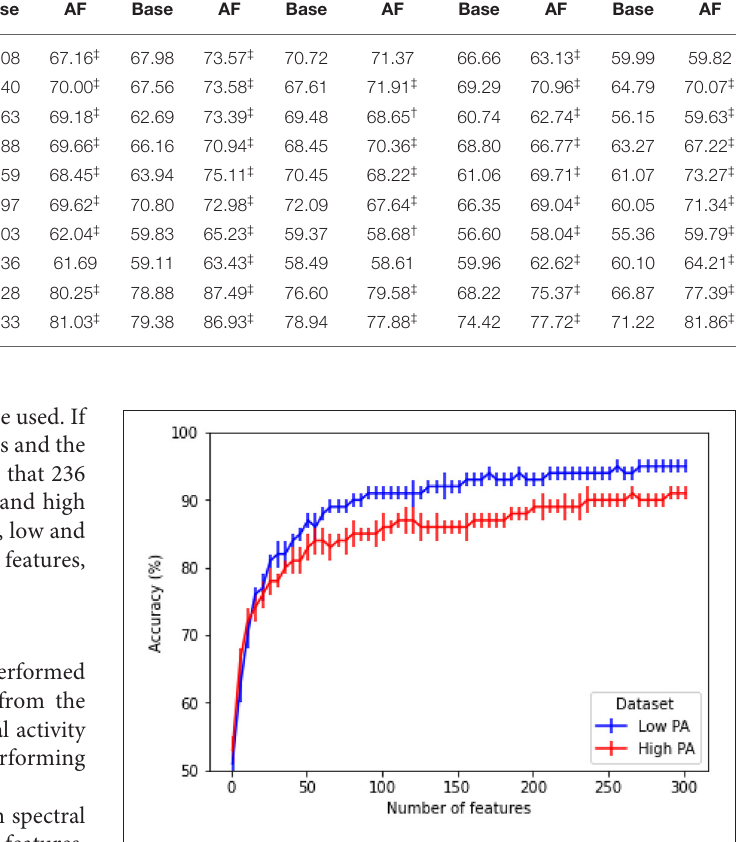
TABLE 2 | SVM mental workload classification accuracy for different feature and enhancement algorithm configurations. Raw ASR ADJUST HAPPE ASR_ADJUST ASR_wICA wICA SVM